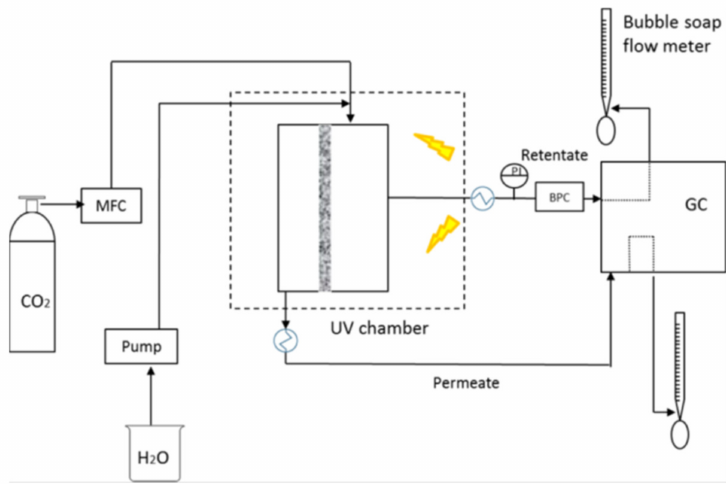
Figure 2. Scheme of photocatalytic membrane reactor setup